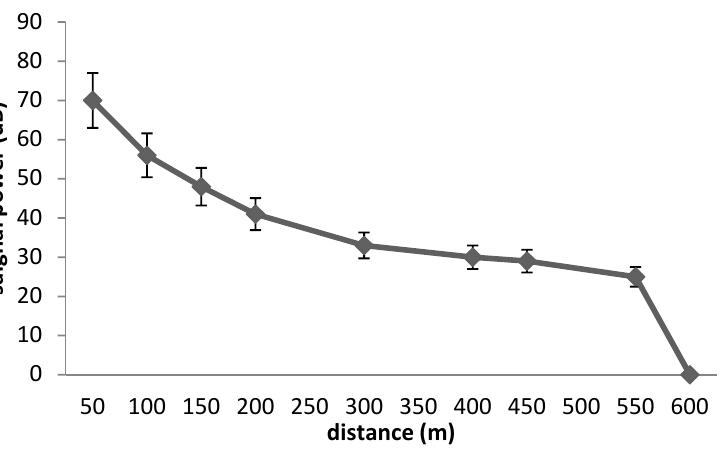
Figure 2. Relation between distance and signal power for V9